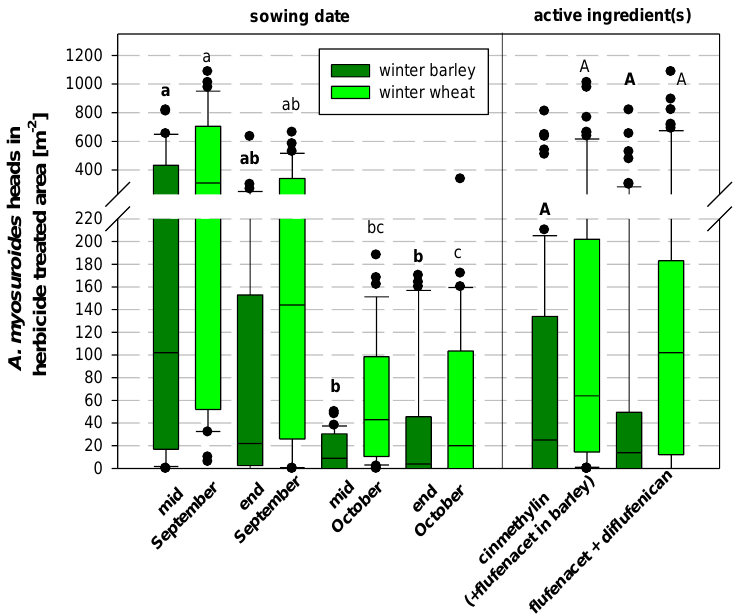
Figure 4. A. myosuroides heads in herbicide-treated areas [m −2 ] in winter barley and winter wheat depending on sowing and used active ingredient(s) (winter wheat: 500 g cinmethylin ha −1 , winter barley: 250 g cinmethylin ha − 1 + 144 g flufenacet ha −1 , both crops: 240 g flufenacet + 120 g diflufenican ha −1 ), box = 25% and 75% quartile, bold line = median, error bars = 5th and 95th percentile, black circles illustrate outliers, different letters indicate significant differences between sowing date or herbicide treatment (bold letters: winter barley), p ≤ 0.05, Tukey-HSD-Test.